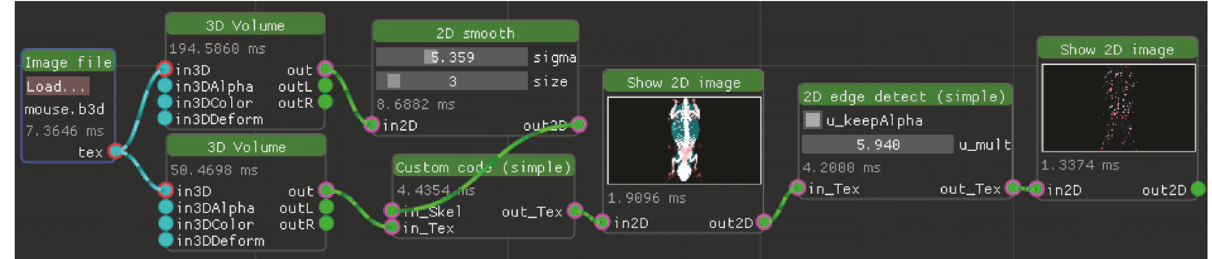
Figure 7: A dataflow graph to visualize a mouse CT volume. Both “3D Volume” nodes render a volume texture into a 2D image, given individual settings. In this example, the resulting 2D image is set to 4K resolution (3840 × 2160). An estimate of the time in milliseconds that a node spent computing on the GPU is displayed on each node, respectively. Any parameter/image changes propagate downstream, so that the whole graph updates itself as